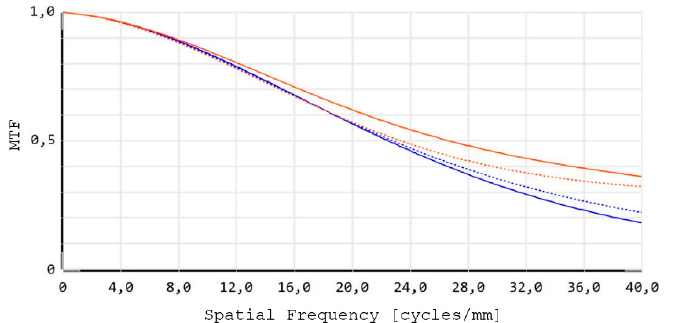
Figure 3. MTF of the manufactured optics compared with the nominal design.